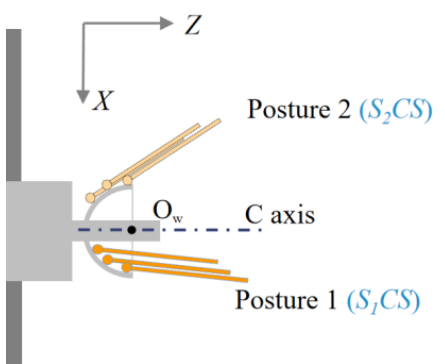
Figure 8. Measurement process for the concentricity of the inner and outer spherical surfaces.